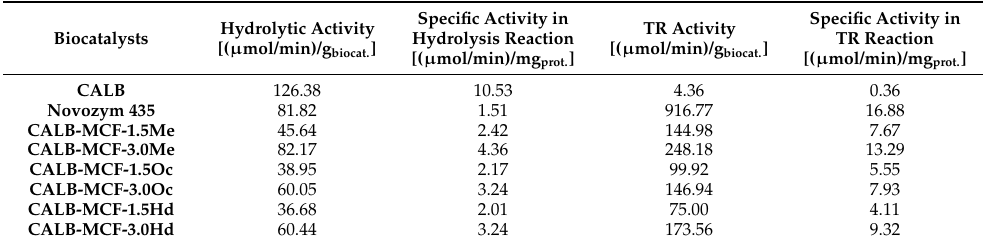
Table 2. Biocatalysts performance in hydrolysis of p -nitrophenyl acetate (aqueous environment) and in transesterification (TR) of ( rac )-1-phenylethanol (organic solvent). Biocatalysts Hydrolytic Activity [( µ mol/min)/g